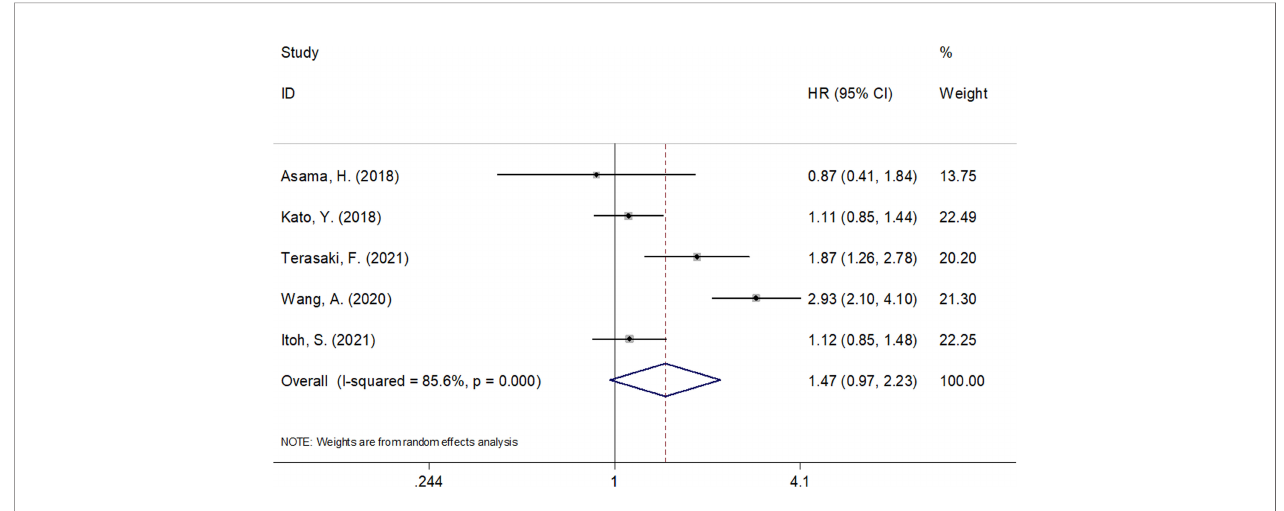
( Table 3 ). However, the CONUT score was not signi fi cantly associated with RFS irrespective of treatment or the cutoff CONUT value.